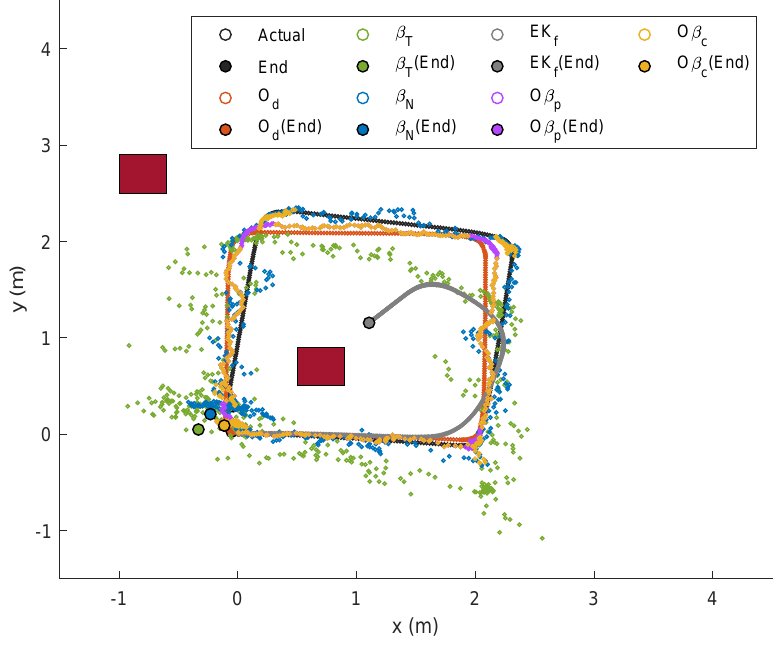
Figure 10. Localization of Node M in the XY -plane for Trajectory 1 experiment.